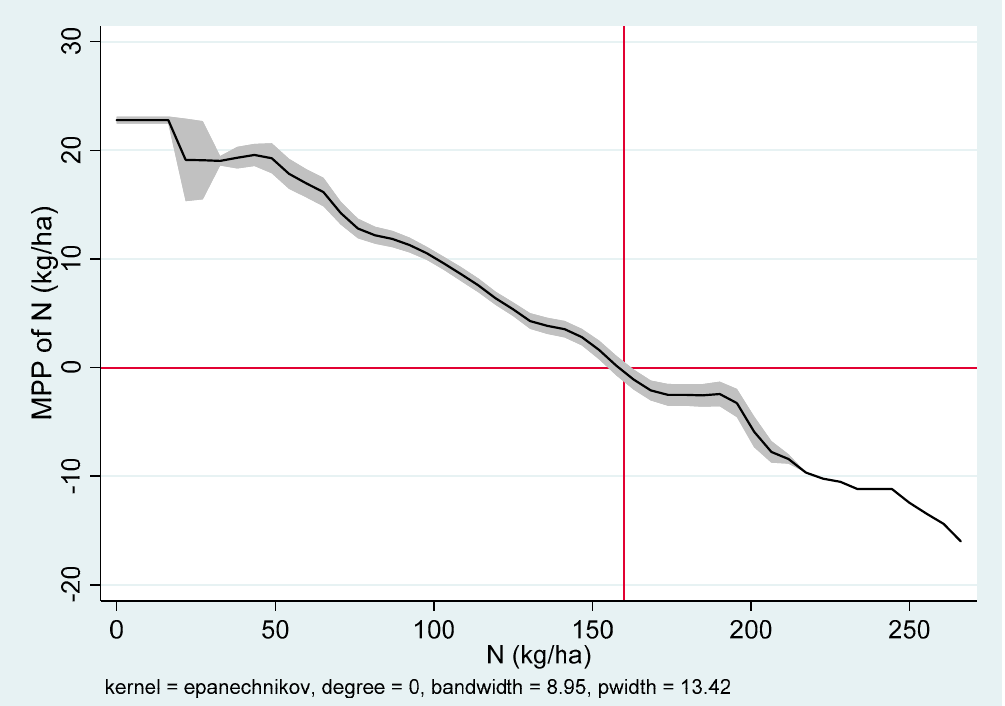
Figure 3. Marginal physical product of N ( MPP N ) at the mean level in Sukamandi, West Java, Indonesia.